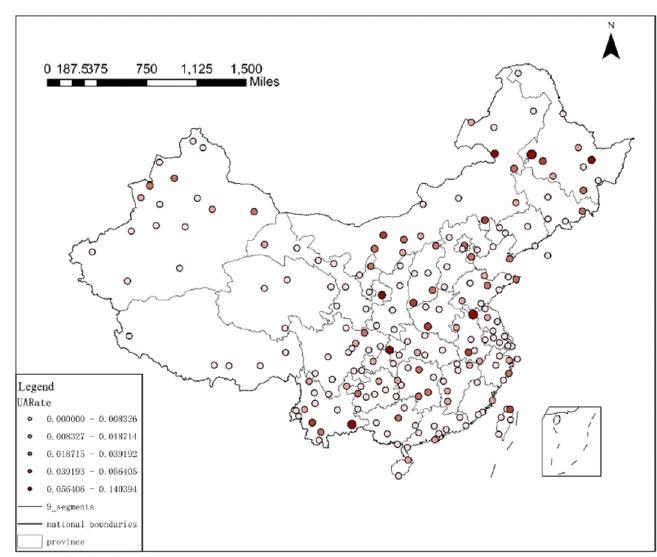
Figure 2. Spatial pattern analysis of UA frequencies.